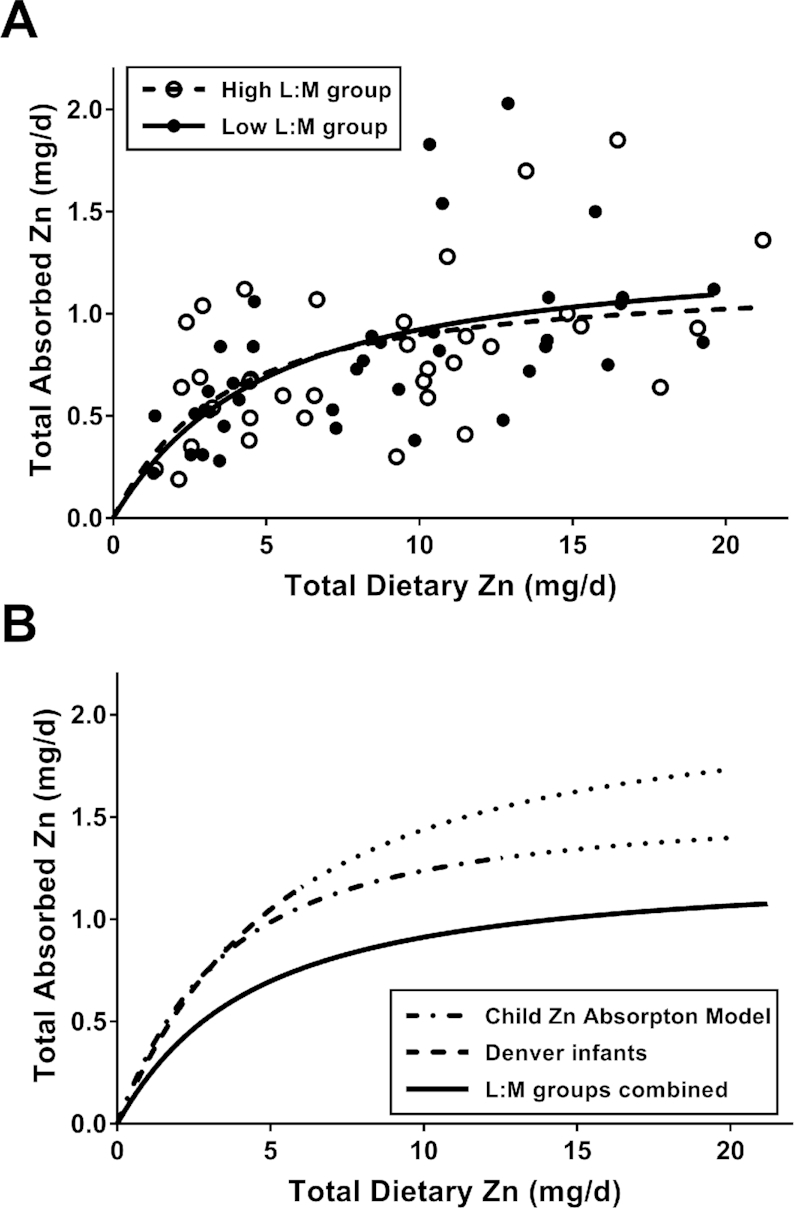
The relation of total absorbed zinc to total dietary zinc intake in Bangladeshi toddlers (A) grouped by high (≥0.09) and low (<0.09) L:M and (B) compared with reference data. (A) The curves show the similar fits of a saturation response model to each L:M group. The parameter data for the curves are presented in Table 4. (B) Comparison of the combined data from (A) to similar modeling of data from a study of breastfed infants in Denver (28) (highest curve) and from the analysis of data compiled from multiple studies of zinc absorption in infants and children (38). The curve representing the latter model shows the prediction for infants of age 19 mo, the mean age of the subjects of this study. For both curves from published analyses, the dashed portion of the curve shows the ranges of the data that were modeled in each case and the dotted portion represents the extrapolation of the curve to cover the range of the current data. L:M, lactulose:mannitol ratio.